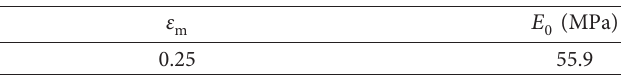
Table 4: Parameters for Salamon’s model.